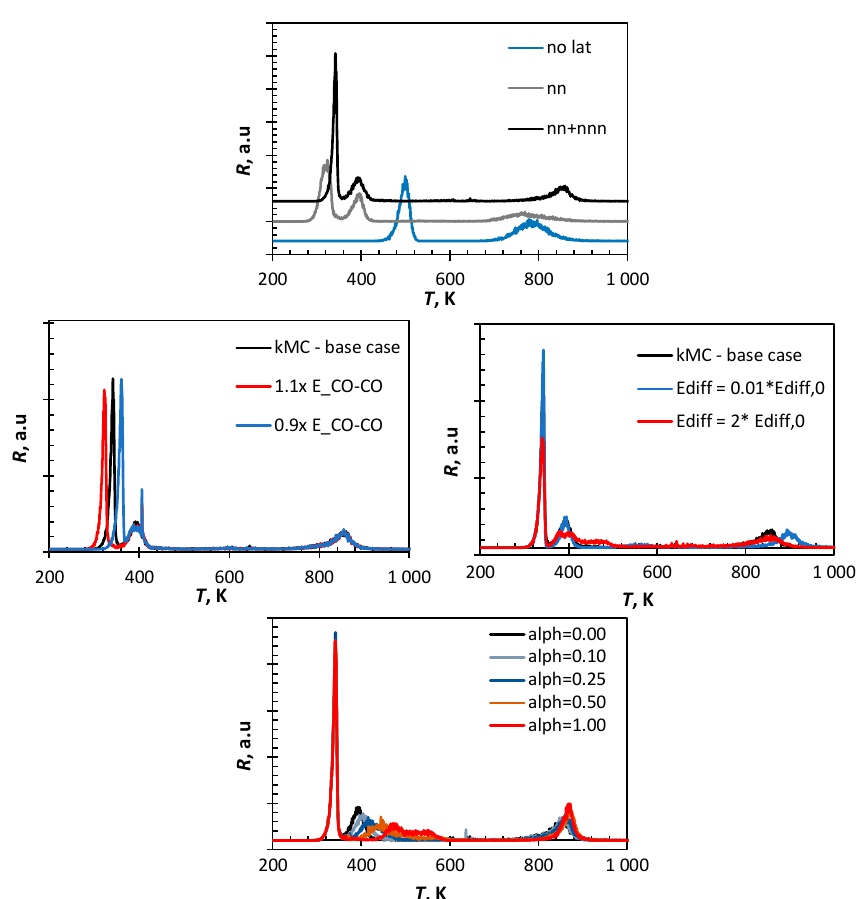
Figure 6. Sensitivity analysis on the parameters in the kinetic Monte Carlo simulation of CO-TPD from Fe(100) ( top : incorporation of no lateral interactions, only nearest neighbor (nn) interactions and nearest neighbor and next-nearest neighbor (nn+nnn) interactions, middle : effect of variation in CO-CO lateral interaction ( left ) and effect of variation in the energy barrier for the diffusion for each of the species, bottom variation in the factor α describing the similarity of the transition state to the initial state ( α = 0) or the final state ( α = 1) in CO-dissociation (see Equation (9)).